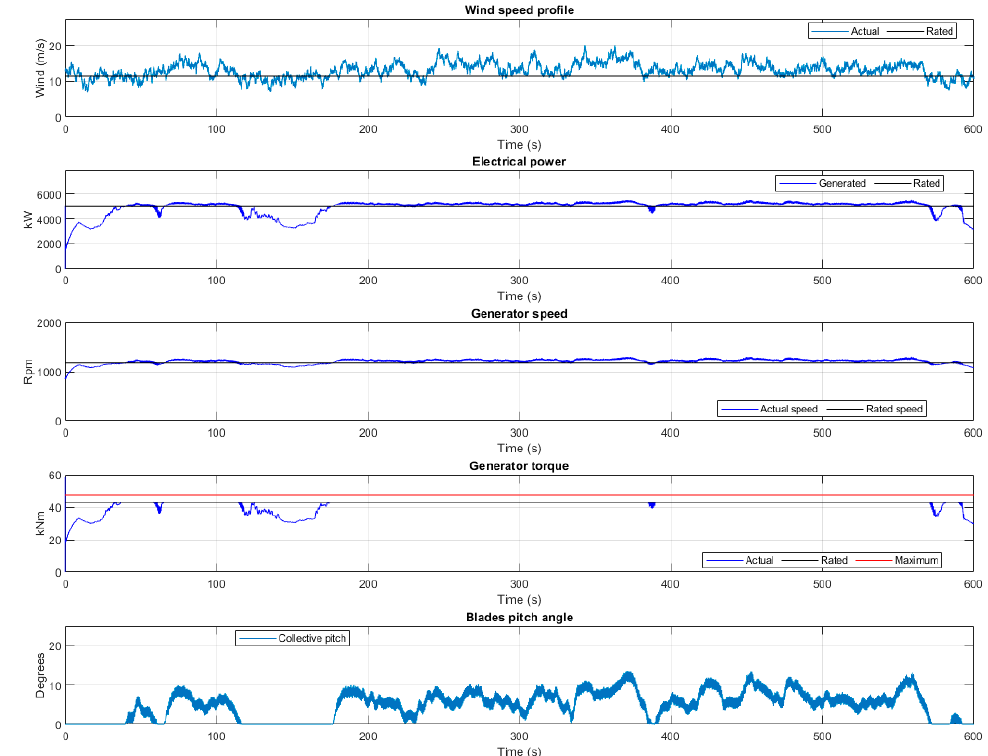
Figure 8. Simulation for reference PI with the Fuzzy Supervisor Control, under a wind profile of average speed of 13 m/s and turbulence A.